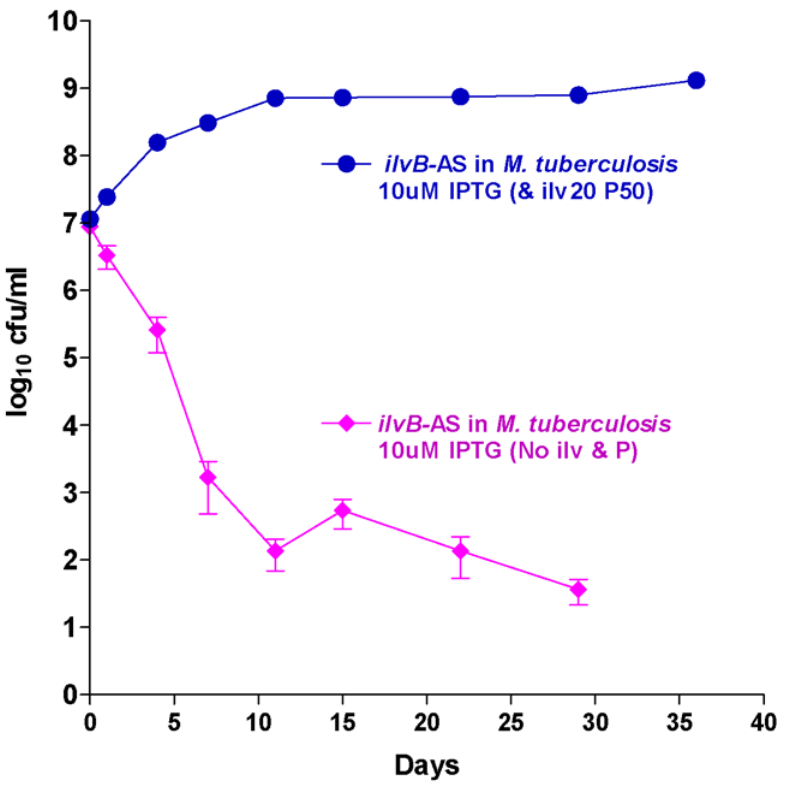
Figure 11. Survival kinetics of M. tuberculosis (with M. tuberculosis ilvB -AS plasmid) . Induction at 10 uM IPTG concentration. The transformants grown in the in the absence of the supplements showed a strong antisense effect with . 3 log10 cfu reduction (bactericidal target). This effect was reversed when grown in the presence of supplements (isoleucine, leucine, valine and pantothenate).